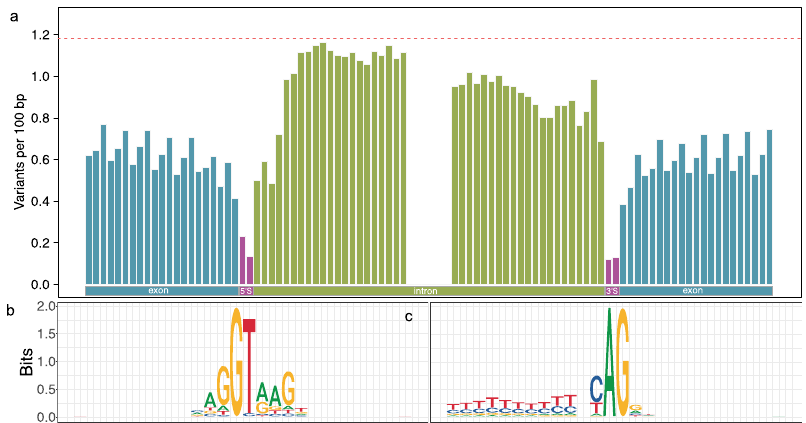
Fig. 2 Evolutionary constraint on splice sites. Variation observed at 21 bases up- and downstream of the 3 ′ and 5 ′ splice sites ( a ). The red dotted line represents the average genome-wide variation. The conservation of nucleotides at 5 ′ ( b ) and 3 ′ ( c ) splice sites is shown in sequence logo